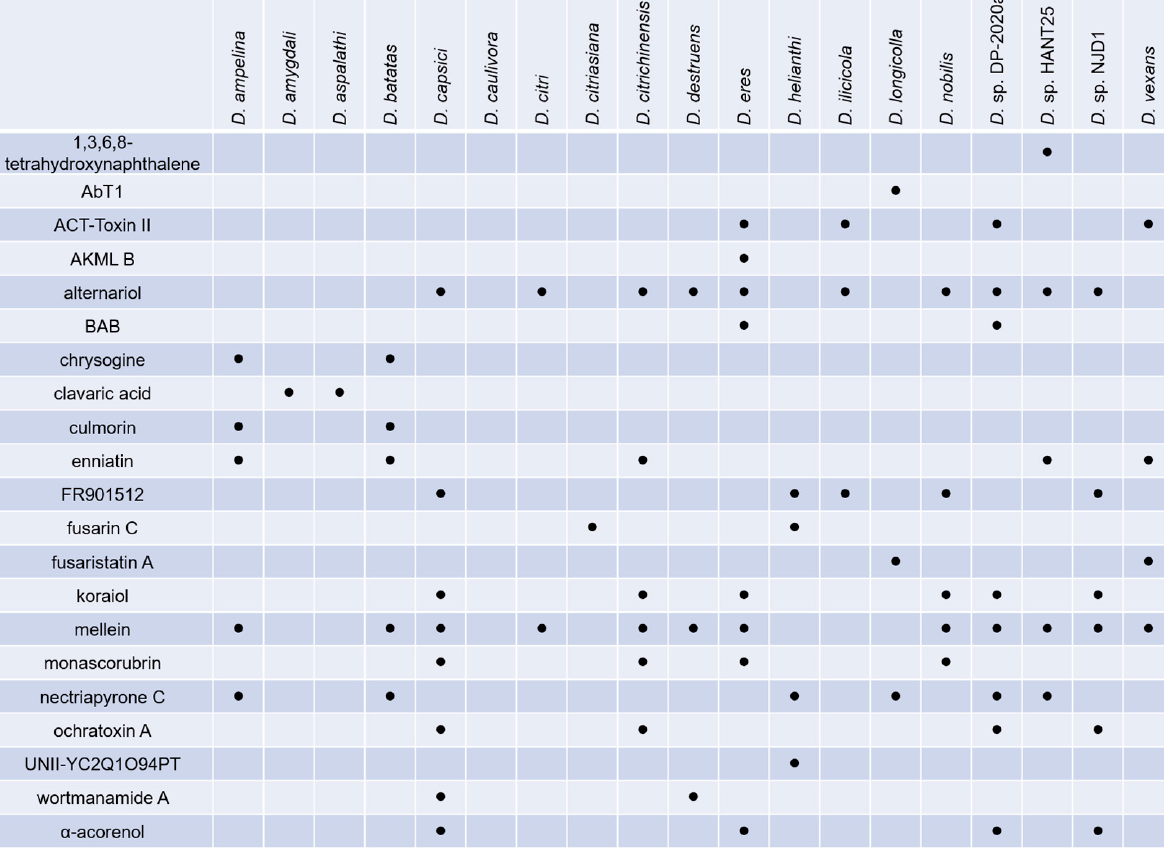
Figure 13. Some secondary compounds produced by species of Diaporthe that are 100% identical to known BGCs.